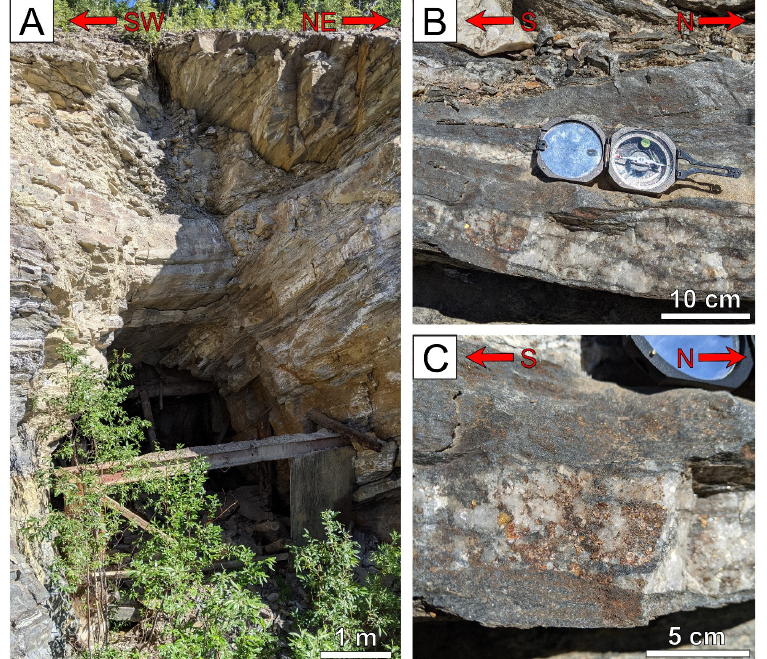
Figure 4. Foliation-parallel veins and boudins in the NW–SE-striking, NW-dipping Nasina Schists, which belong to the Upper Devonian to Mississippian Finlayson Group (DMF3). ( A ) Abandoned adit which cuts through the Nasina schists in the Miller Creek area. ( B , C ) Disseminated sulfide mineralization can be observed in lens-shaped and boudinage quartz veins. Refer to Figure 2 for location. Minerals 2022 , 12 , x FOR PEER REVIEW